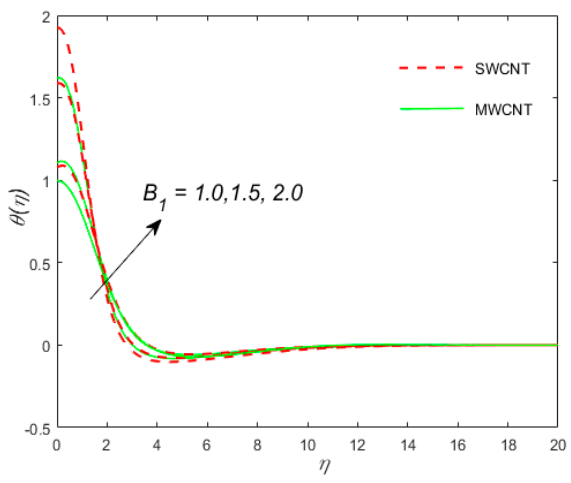
Figure 8. The impact of the temperature distribution profile θ ( η ) for the case of SWCNT and MWCNT versus the similarity variable for the distinct values of the Boit number ( B 1 ).